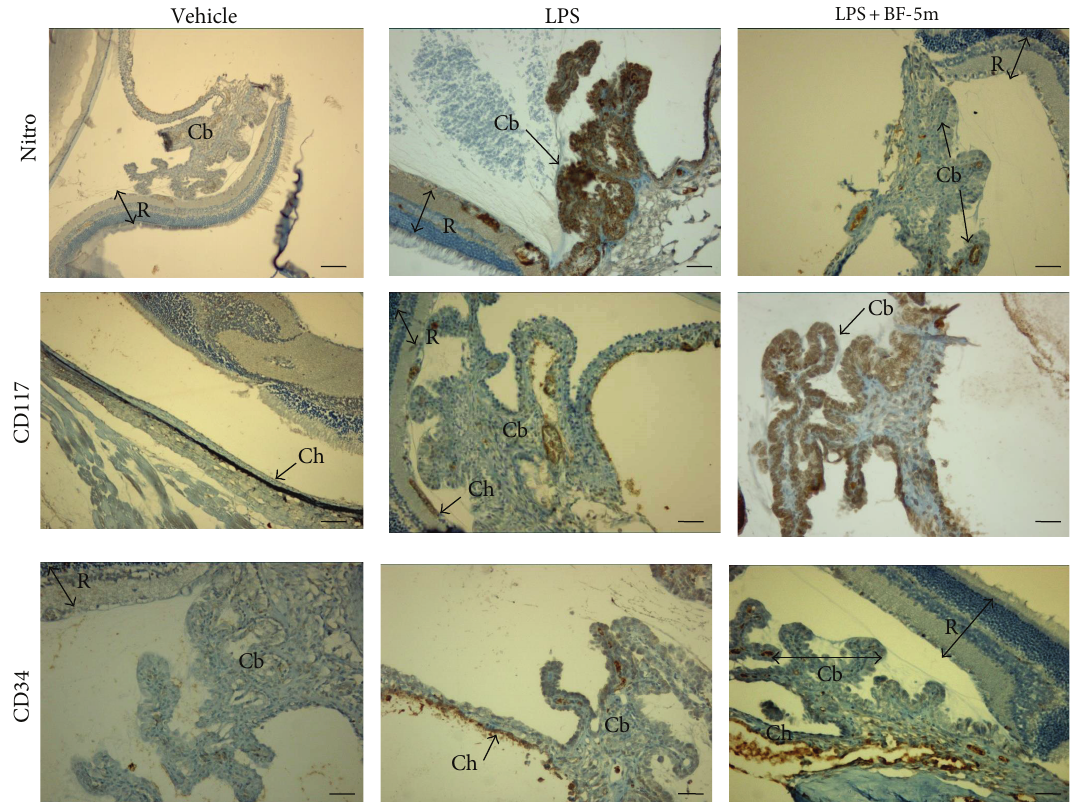
Figure 7: Representative immunohistochemistry for nitrotyrosine, CD117-ckit, and CD34 in the eye structures of rats treated with vehicle, LPS, and BF-5m (0.05 𝜇 M/rat). Intravitreal BF-5m increases CD34 + and CD117 + immunostaining into the eye, while reducing the nitrotyrosine. Nitro: nitrotyrosine; R: retina; Ch: choroid; Cb: ciliary bodies. Scale bar, 50 𝜇 m. 200x